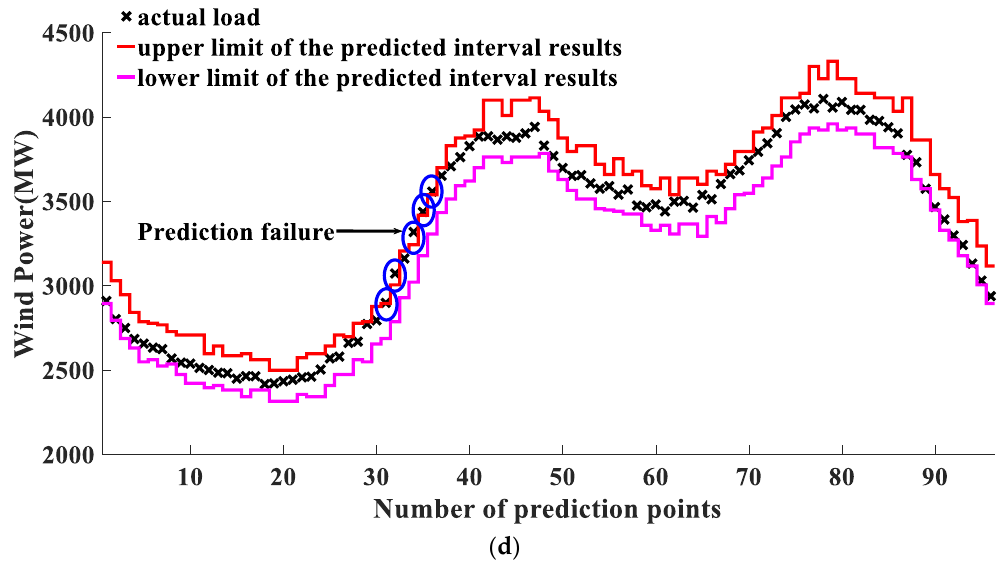
Figure 6. Prediction results of applying four methods in region 3: ( a ) Prediction results based on the optimal parameter K and t ; ( b ) prediction results of ANN algorithm; ( c ) prediction results based on ELM; ( d ) prediction results of GPR algorithm.